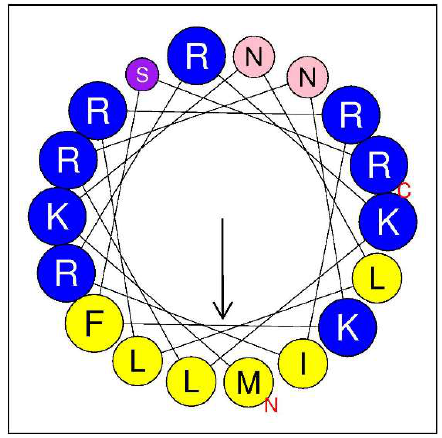
Figure 7. Helical wheel diagram of the N -terminal region of LysC. The projection was obtained from HeliQuest (http://heliquest.ipmc.cnrs.fr/cgi-bin/ComputParams.py). Predicted hydrophobic face includes I, M, L, L, and F. Positively charged residues are highlighted by blue color, while hydrophobic residues are marked in yellow. Polar uncharged residues are represented by purple (S) and pink (N). Size of the analysis window was 18 amino acids. The arrow represents the helical hydrophobic momentum. Int. J. Mol. Sci. 2020 , 21 , x